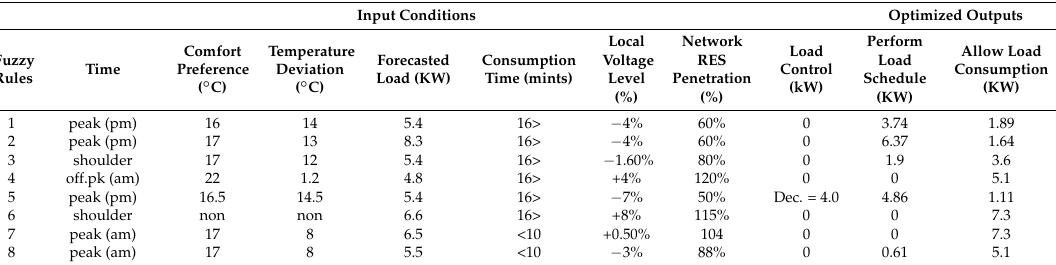
Table 2. Optimized results from the fuzzy load